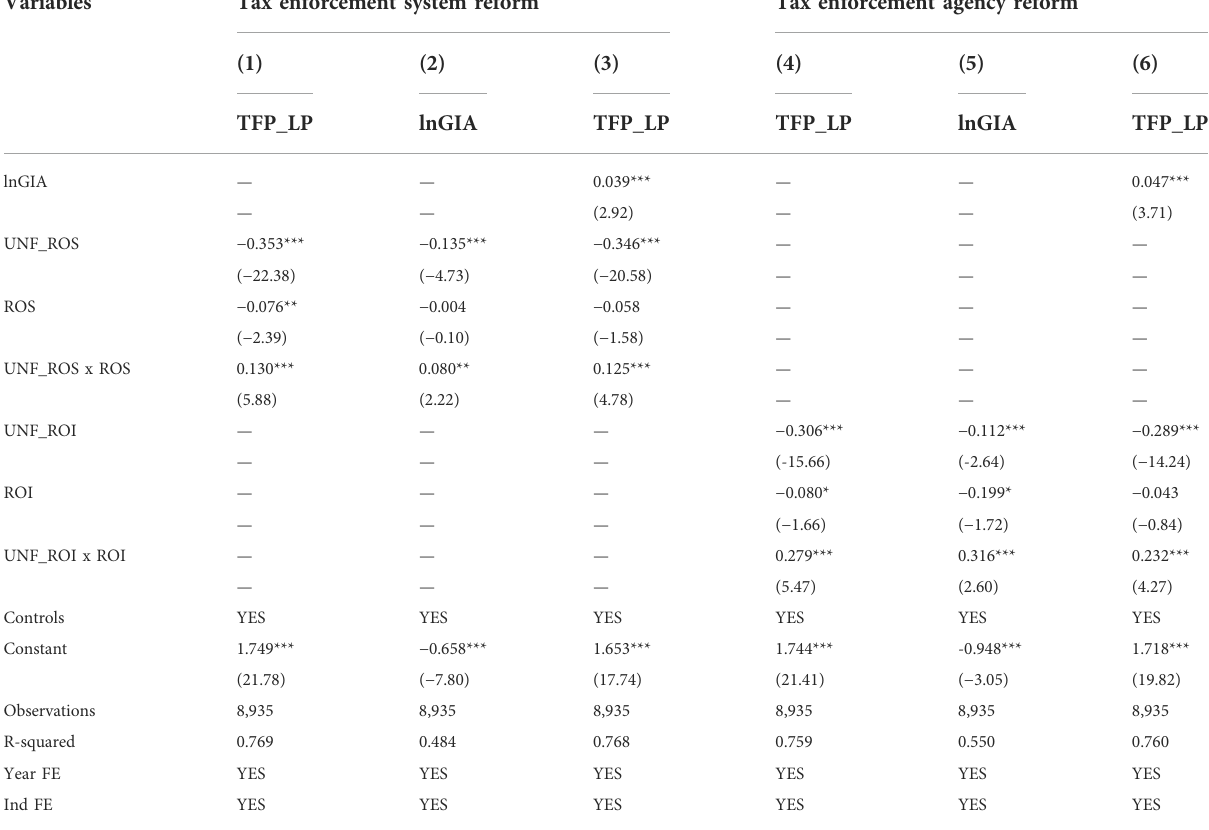
TABLE 11 Mediating mechanism of green invention patent